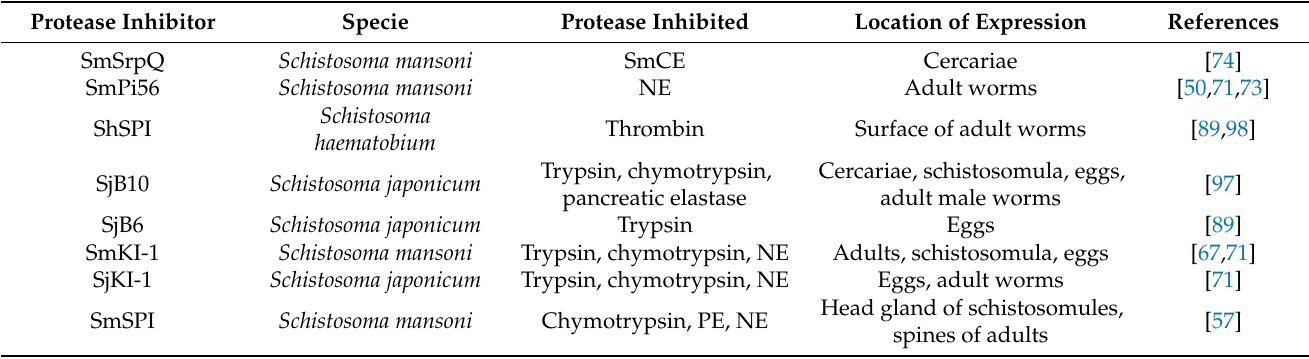
Table 2. Schistosome protease